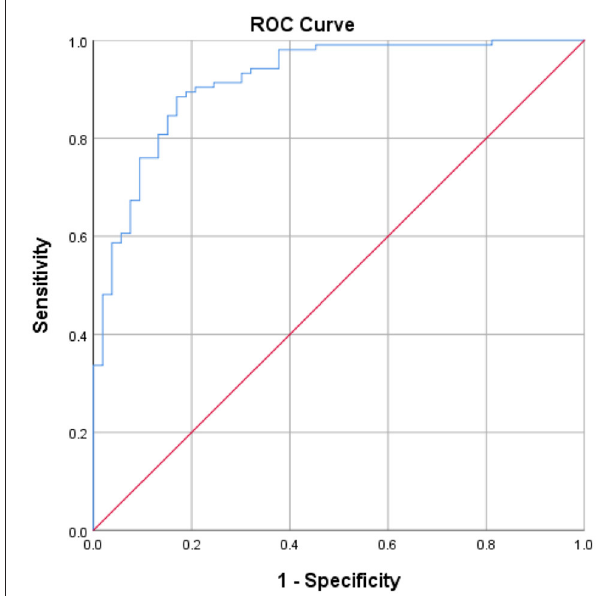
FIGURE 3 | The receiver operating characteristic curves and the value of area under the receiver operating characteristic curve, sensitivity, and specificity for the optimal cutoffs of TWT completion